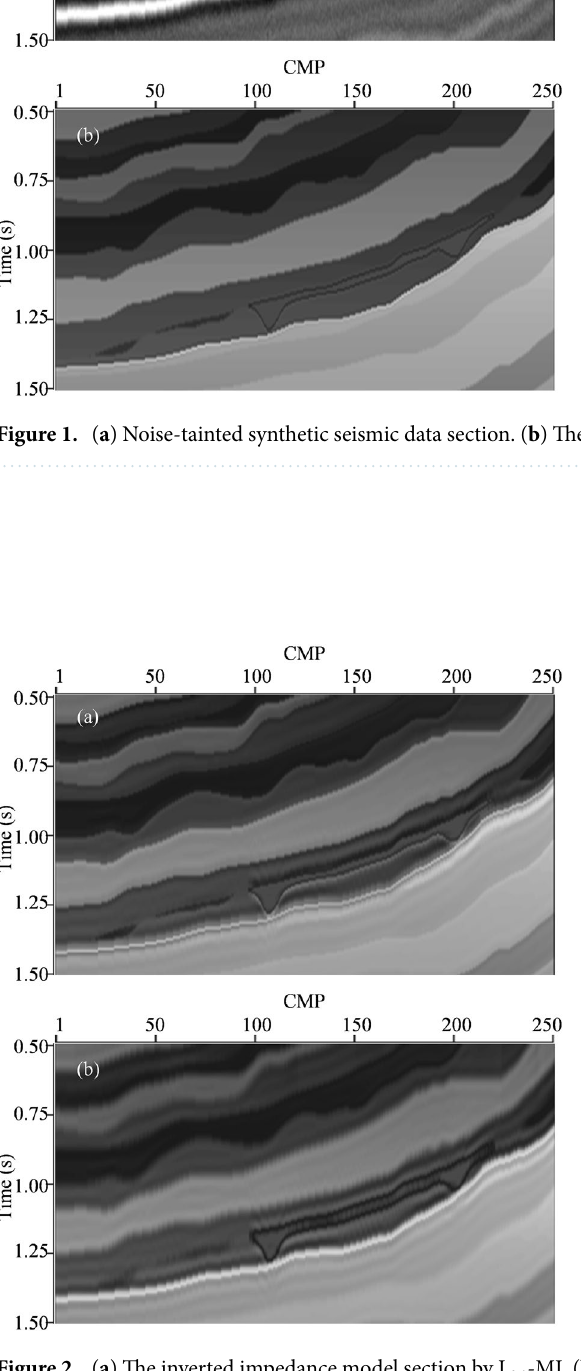
Figure 2. ( a ) The inverted impedance model section by L 2,0 -MI. ( b ) The inverted impedance model section by